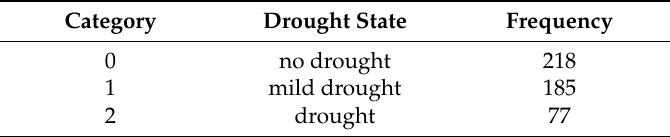
Table 2. Frequency of drought state